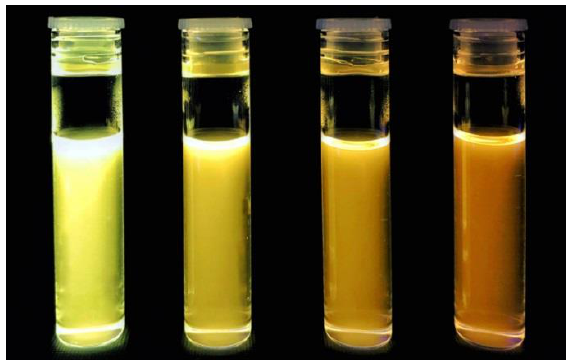
Figure 47. Photograph of oleate-stabilised ZnO NPs, dispersed in cyclohexane, under UV light (λ =